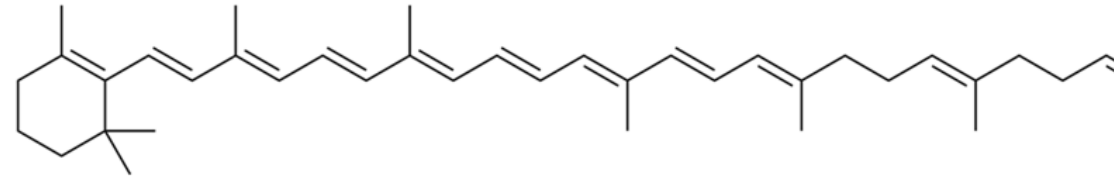
Figure 4. Chemical formula of β